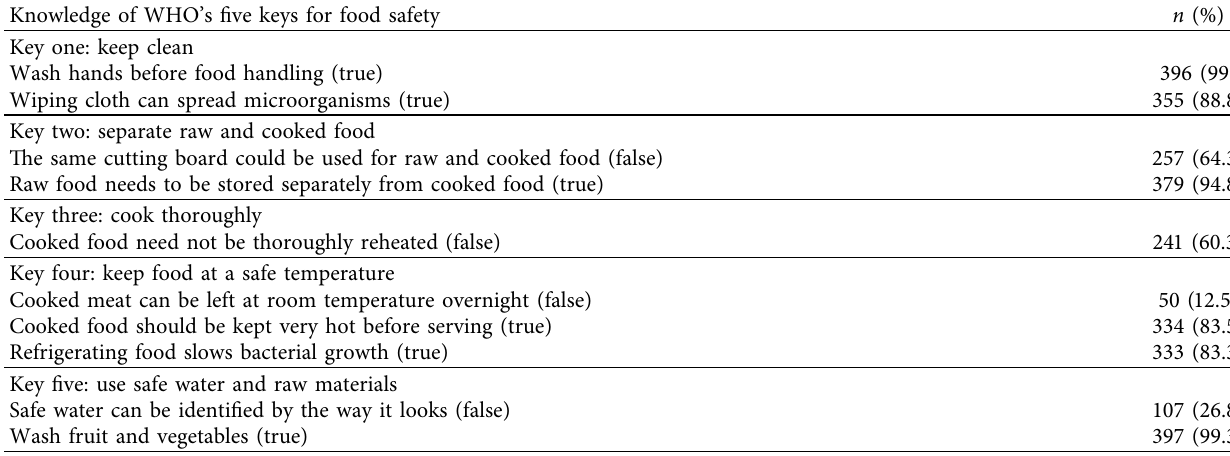
Table 2: Distribution of the study participants according to the knowledge of the World Health Organization’s five keys for food safety ( n � 400). Knowledge of WHO’s five keys for food safety